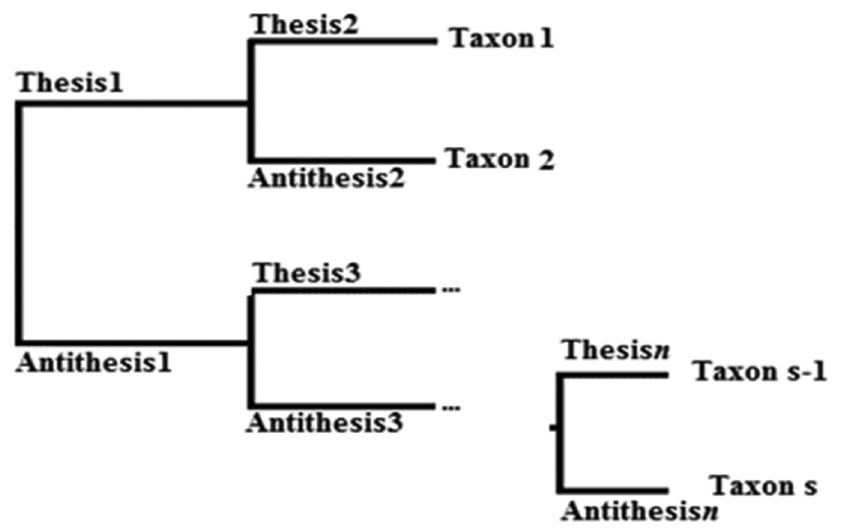
Figure 2. Schematic presentation of a dichotomous